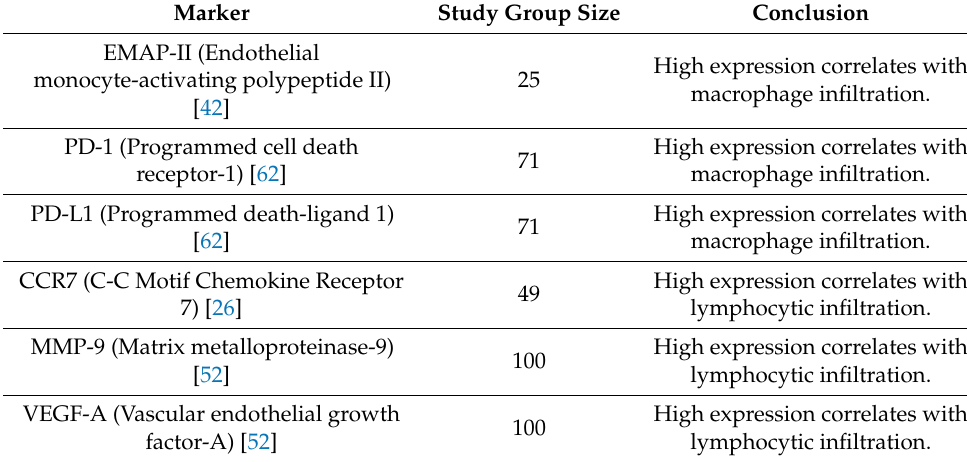
Table 9. Summary of markers whose expression is related to TIMs and TILs infiltration. Marker